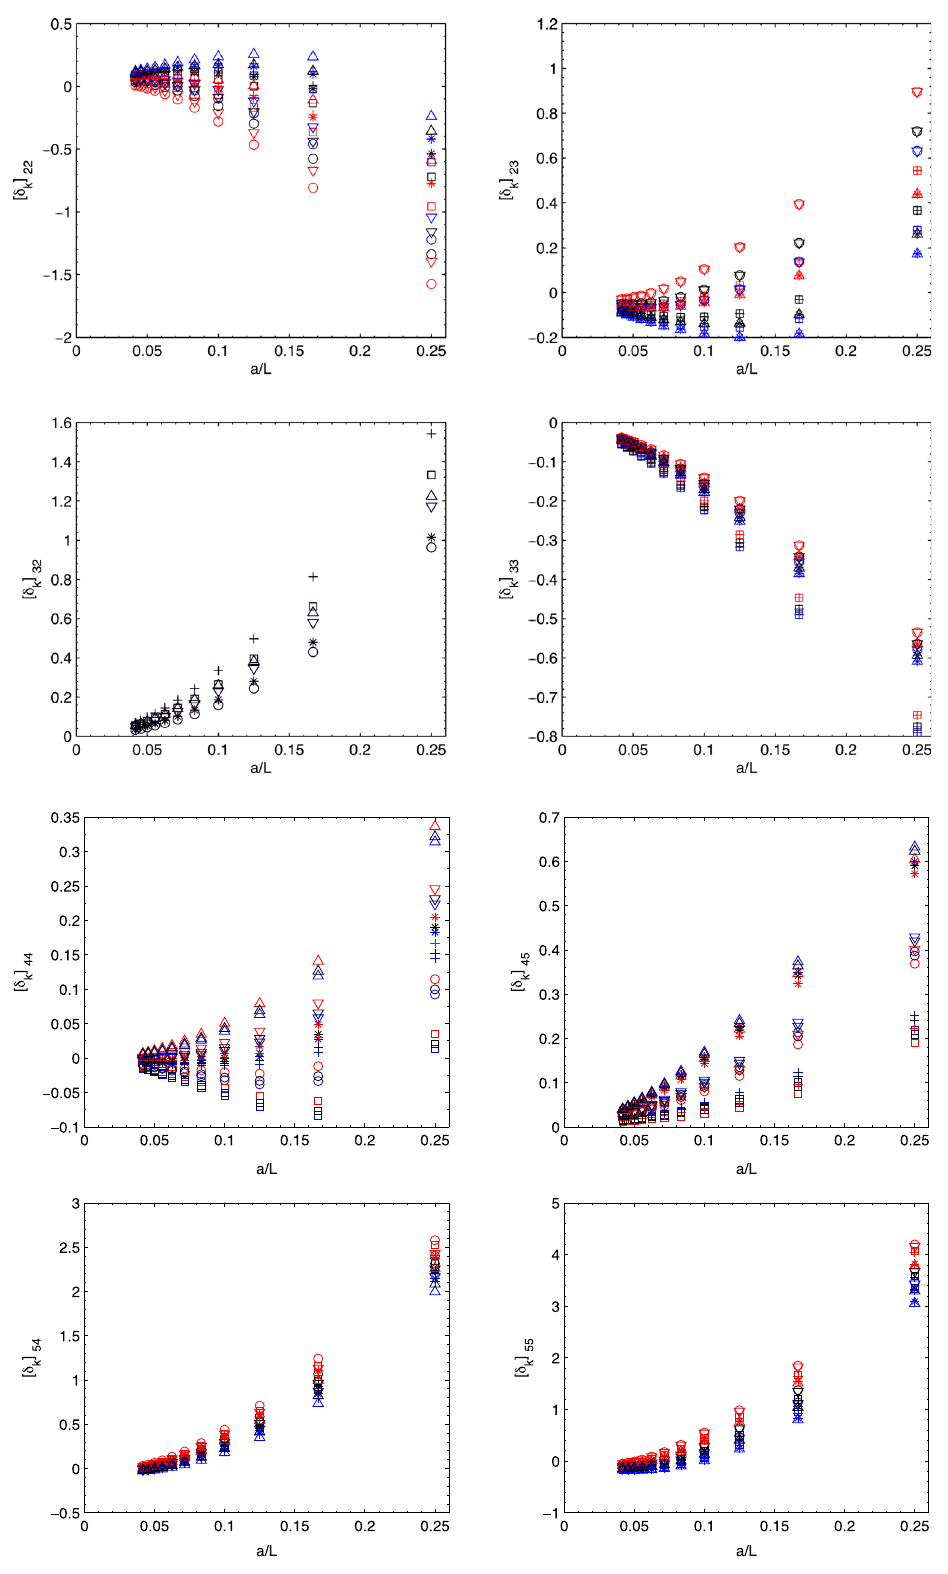
, Q − } (top) and { Q − , Q − } (bottom). Different colours distinguish 2 3 4 5